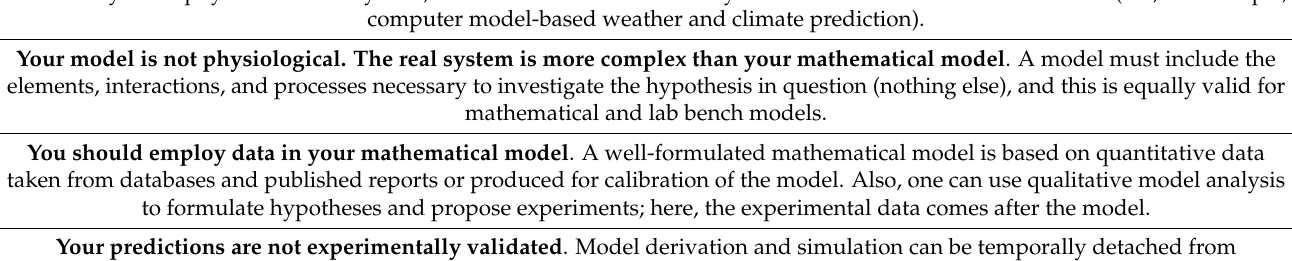
Table 1. Top misunderstandings on modelling and how to fight